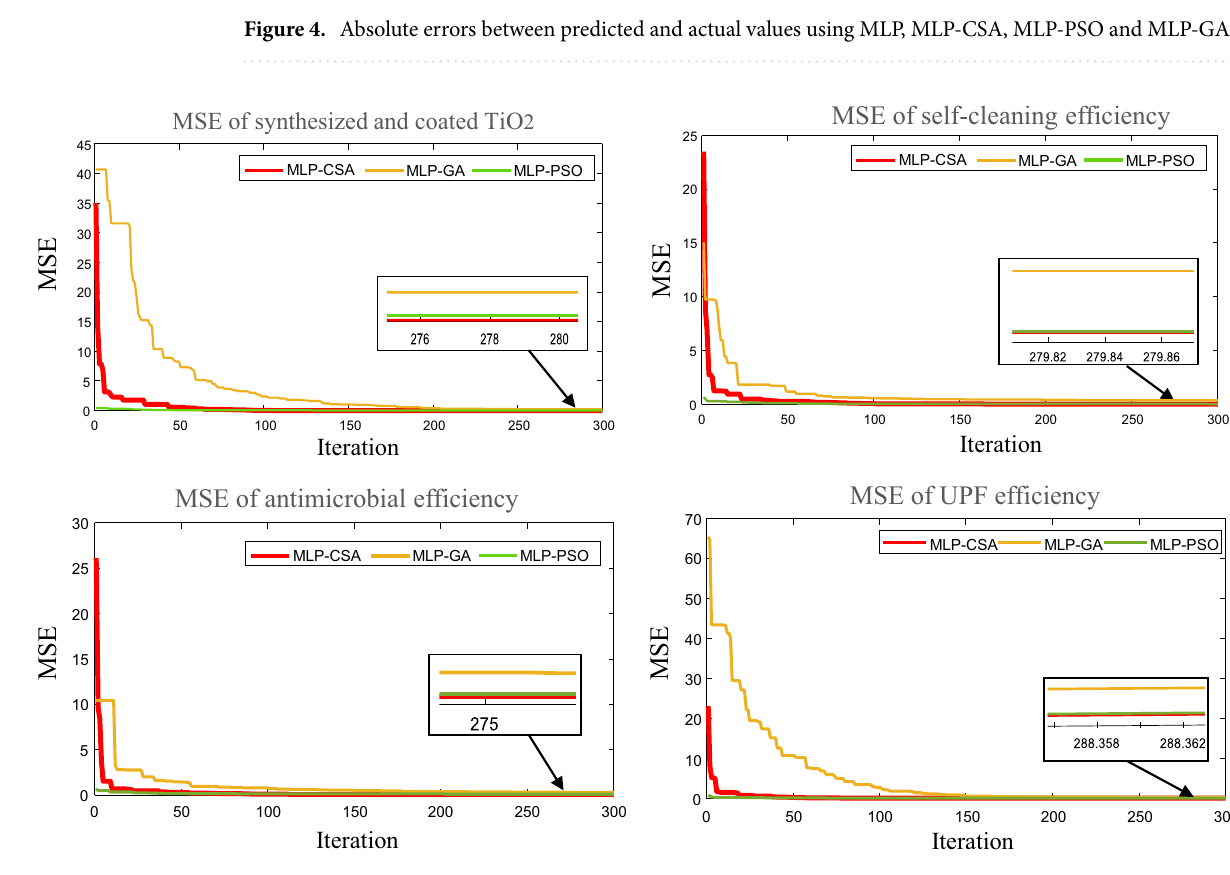
Figure 5. Performance MSE convergence characteristics for MLP-CSA, MLP-PSO and